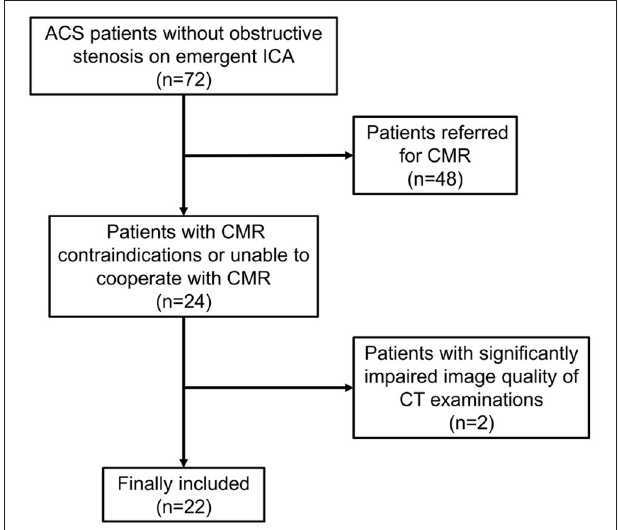
FIGURE 1 | Flow chart of patient inclusion and exclusion. ACS, acute coronary syndrome; CMR, cardiac magnetic resonance; CT, computed tomography; ICA, invasive coronary angiography.